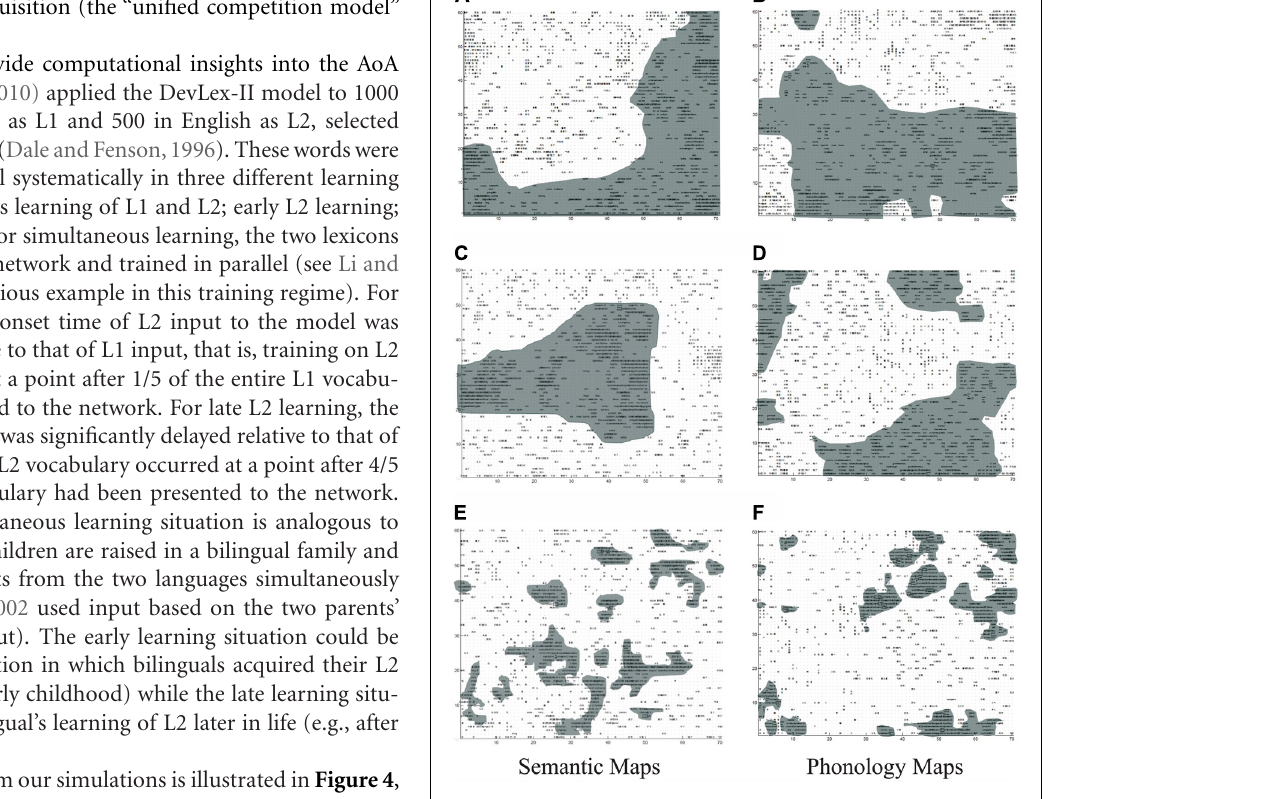
FIGURE 4 | Bilingual lexical representation of semantics and phonology respectively as a function of age of acquisition (AoA). Dark areas correspond to L2 (English) words. (A,B) Simultaneously learning; (C,D) early L2 learning; (E,F) late L2